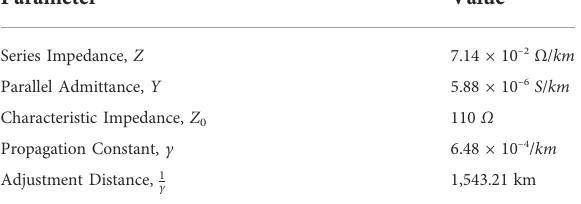
TABLE 3 Transmission line parameters for test